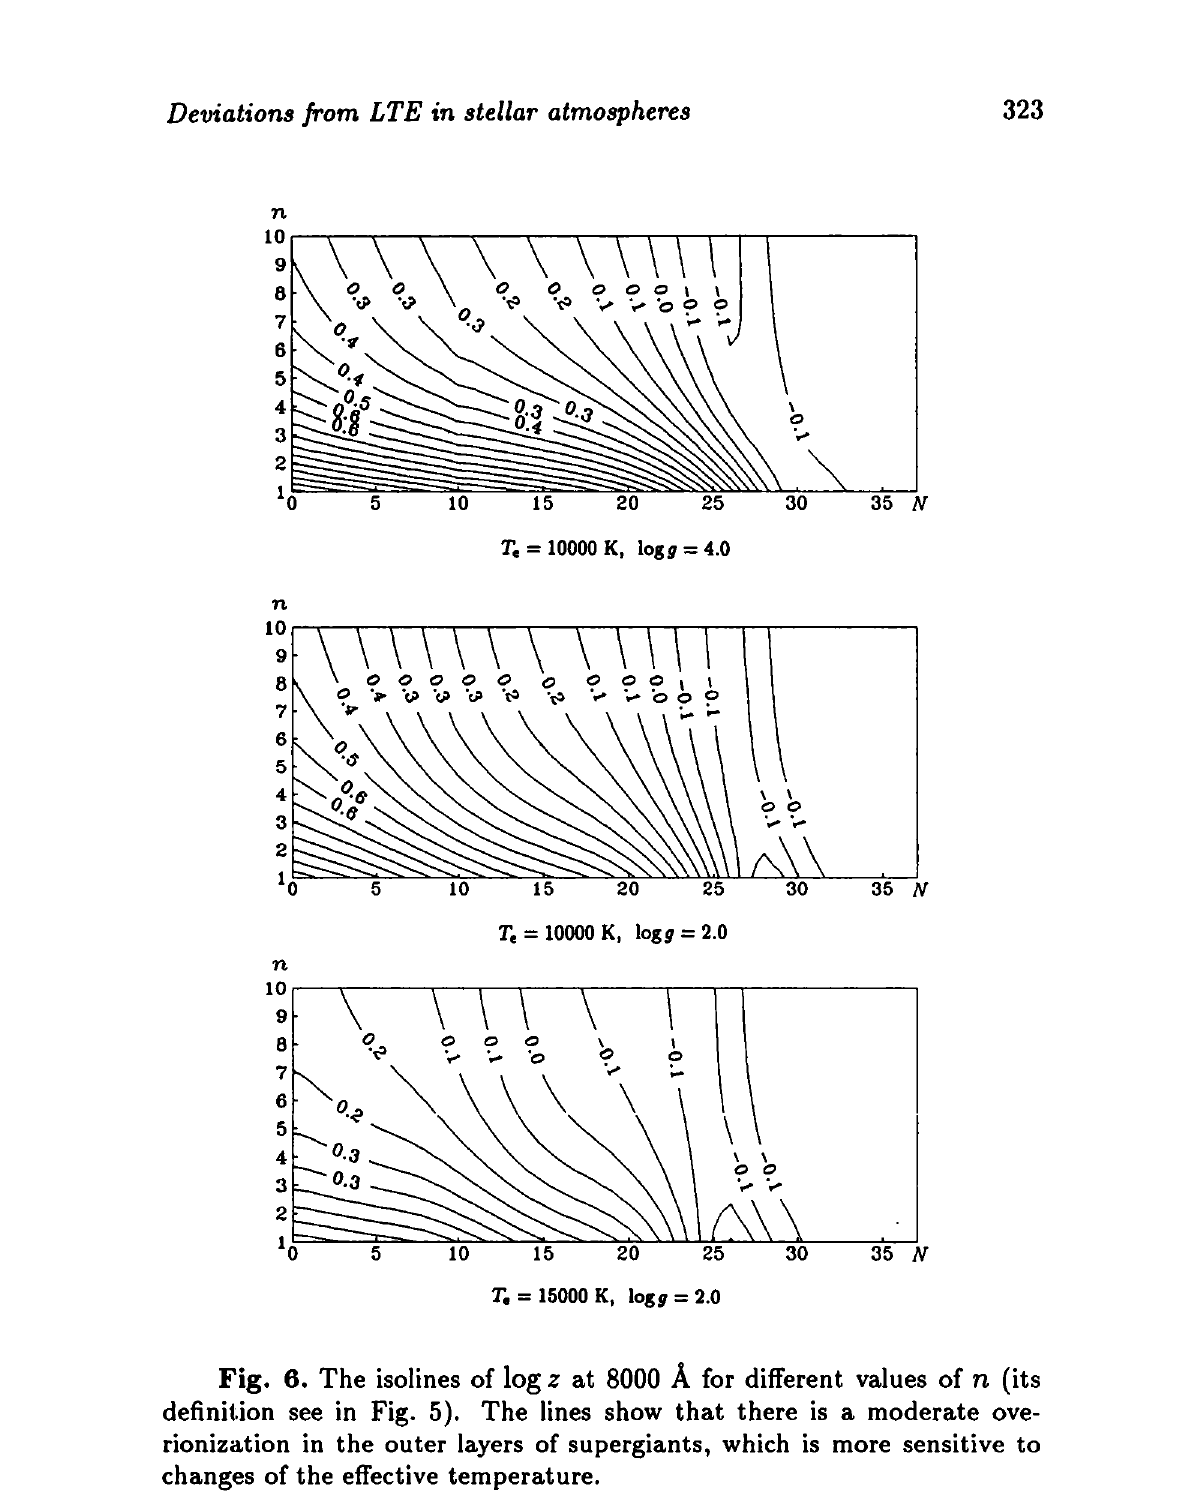
Fig. 6. The isolines of log ζ at 8000 Ä for different values of η (its definition see in Fig. 5). The lines show that there is a moderate ove- rionization in the outer layers of supergiants, which is more sensitive to changes of the effective